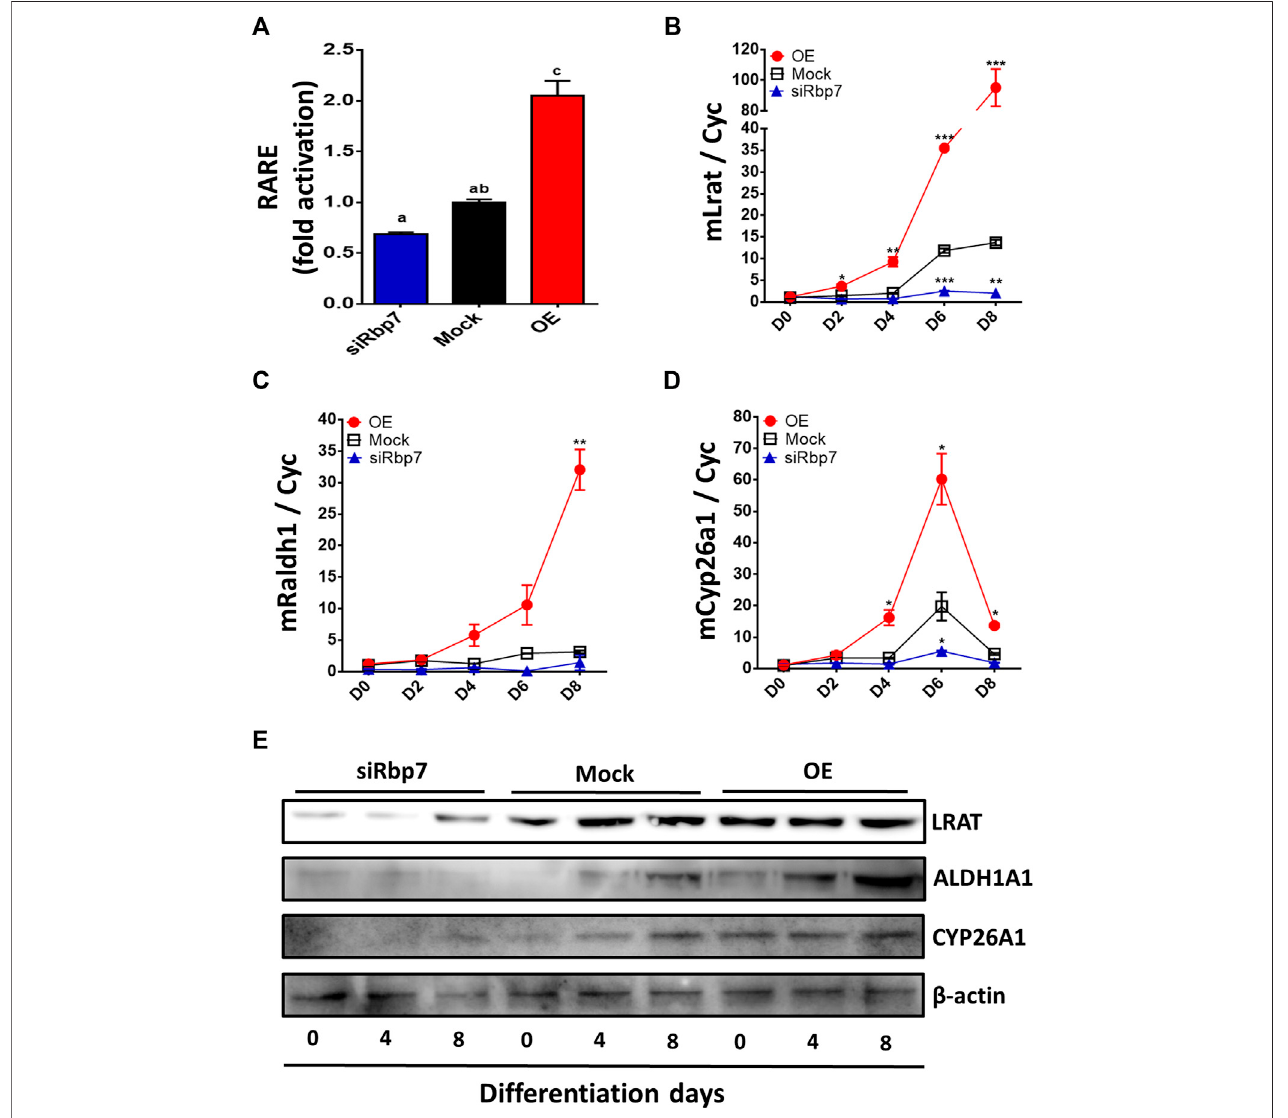
FIGURE5| EffectsofRbp7onnuclearretinoicacidlevelsandexpressionofretinoidmetabolicgenes. (A) RAREluciferaseactivityafter48 htransfectionon3T3-L1 cells. The values were normalized by activity levels of Mock. (B – E) Quantitative analysis of diverse markers associated with retinoid metabolism on differentiated 3T3-L1 cells. Cyc wasusedashousekeepingcontrol.Redcircle:OEgroup;Blackrectangular:Mockcontrol;Bluetriangle:siRbp7group.D0-8:preadipocytedifferentiationday. (G) Western blotanalysisofretinoid metabolism. Values present means ± SEM. Forthe statistical analysis, the letters (a, ab, or c) were used toshow the signi fi cant difference (A) and the data were compared on each time point among different groups (OE vs. Mock vs. siRbp7) to analyze signi fi cant difference (B – E) . All statistical analysis were compared using one-way ANOVA followed by Tukey ’ s multiple comparisons test. * p < 0.05, ** p < 0.01, *** p < 0.001.